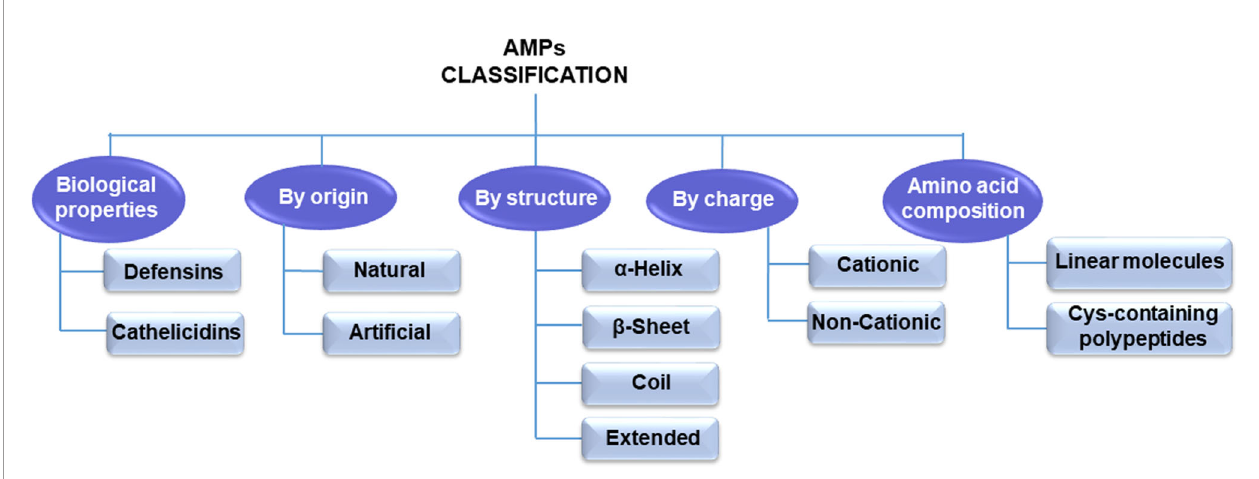
FIGURE 2 | Antimicrobial peptide classi fi